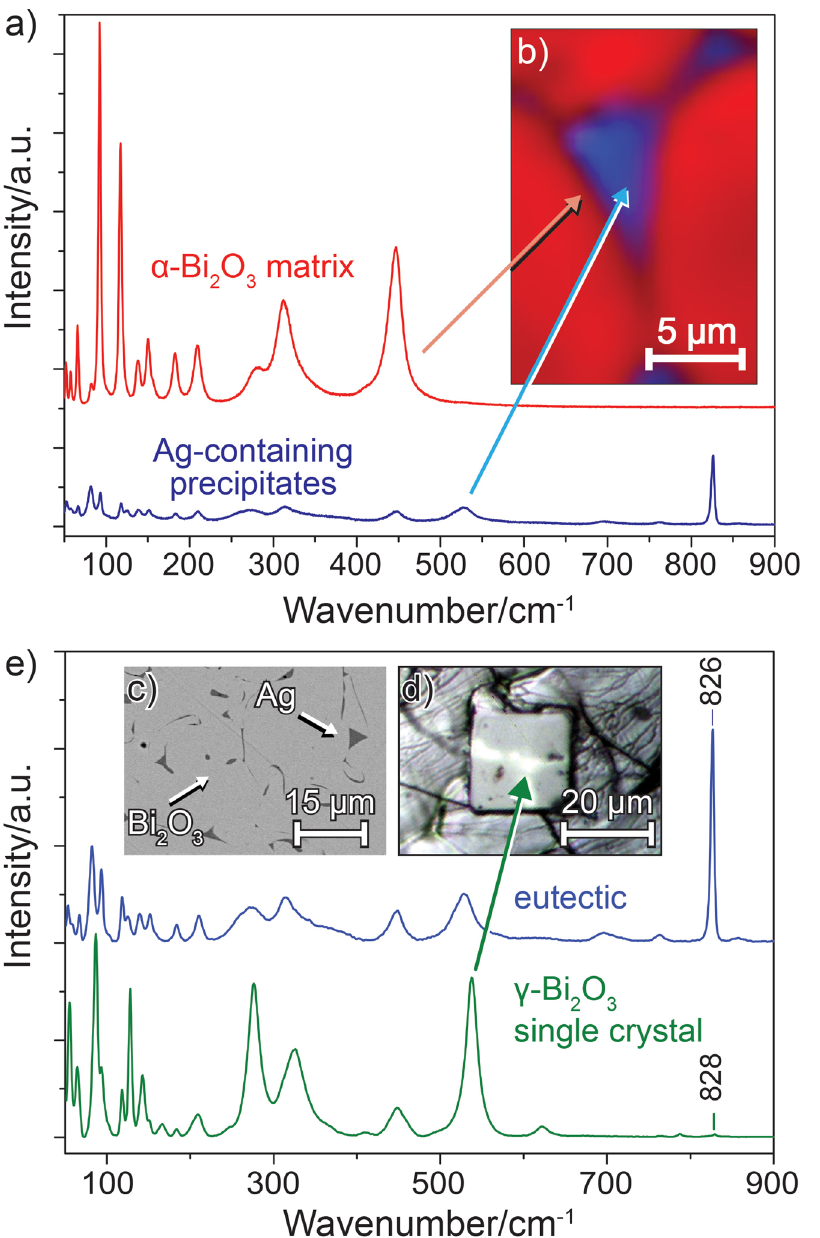
Figure 1: Microstructure and selective SERS observed in the volumetric eutectic-based Bi 2 O 3 -Ag composite exhibiting LSPR at visiblewavelengths.Ramanspectra(a)and map (b) presenting the contrast between areascontainingsilverprecipitatesandthe matrix of the composite. Red colour (spec- trum and map) is assigned to the α -Bi 2 O 3 phase (the 450 cm − 1 peak intensity); blue represents the γ -Bi 2 O 3 phase (illustrating the intensity of the 826 cm − 1 peak charac- teristic of this phase). (c) SEM image of the micro-/nanostructure of the composite: light grey – Bi 2 O 3 matrix, dark grey – Ag- containing precipitates. (d) The optical im- age of the γ -Bi 2 O 3 single crystal. (e) Strong enhancement speci fi cally of the γ -Bi 2 O 3 phase band at 826 cm − 1 for the Bi 2 O 3 -Ag eutectic composite in Ag-containing pre- cipitates (blue line) in comparison with the γ -Bi 2 O 3 single crystal (green line), λ exc = 532